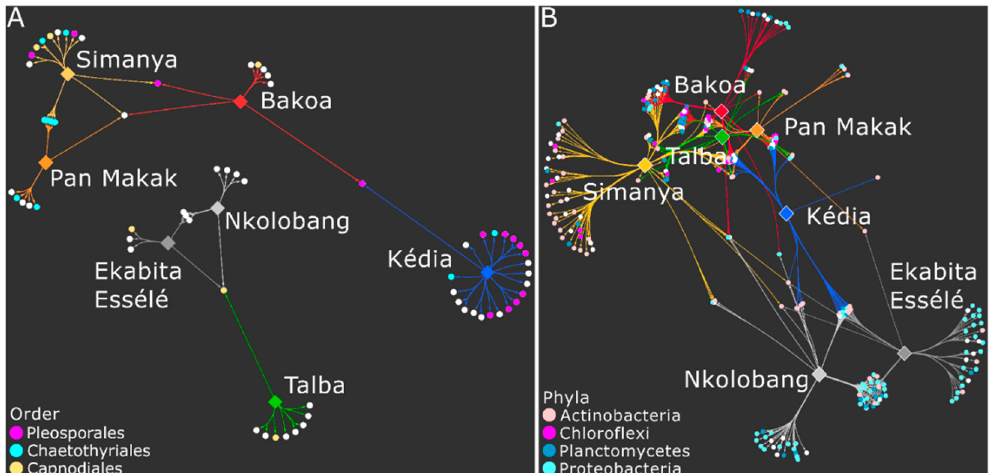
Figure 5. Bipartite association network of fungal ( A ) and bacterial ( B ) zOTUs in T. cacao leaves significantly associated with site. The sites are color-coded as in Figure 1. Bacterial phyla and fungal orders, which were predominant in the dataset and / or in one site, are highlighted.